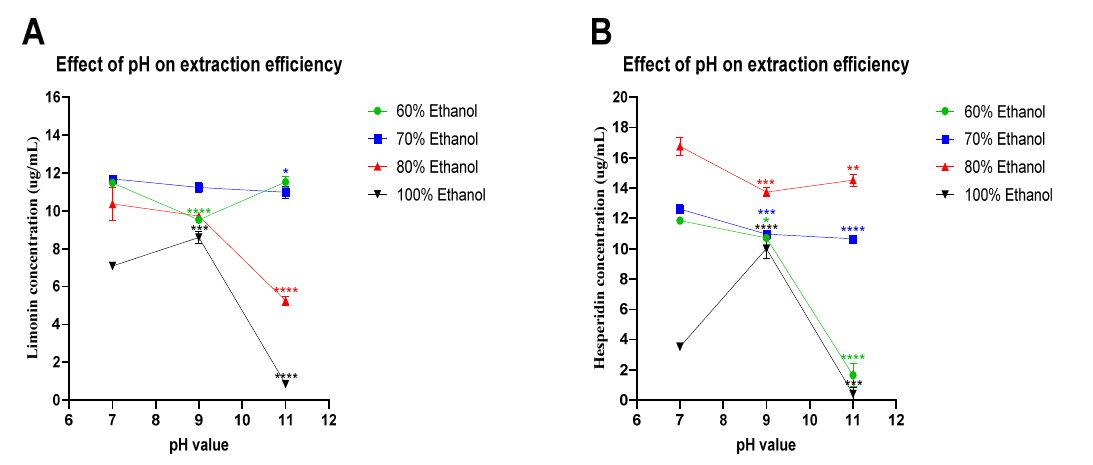
Figure 2. Effect of pH on extraction efficiency. Limonin ( A ) and hesperidin ( B ) concentrations in the ethanolic-aqueous extracts of lime peel after extraction with 60% ( ● ), 70% ( ■ ), 80% ( ▲ ), and 100% ( ▼ ) ethanol in water with the specified pH values at 50 °C for 100 min. The statistical differences were separately analyzed for limonin and hesperidin by using one-way ANOVA followed by Tukey’s multiple comparisons test. * , **, *** and **** mean p < 0.05, < 0.01, < 0.001 and < 0.0001, respectively, compared with the concentrations of limonin or hesperidin at pH 7 of each specified condition.